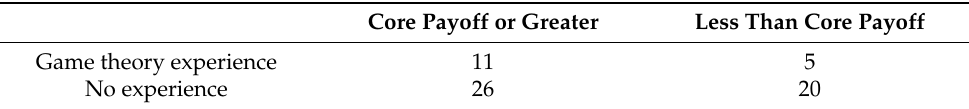
Table 5. A contingency table shows the impact of game theory experience on whether human participants’ final payoff was a core payoff.